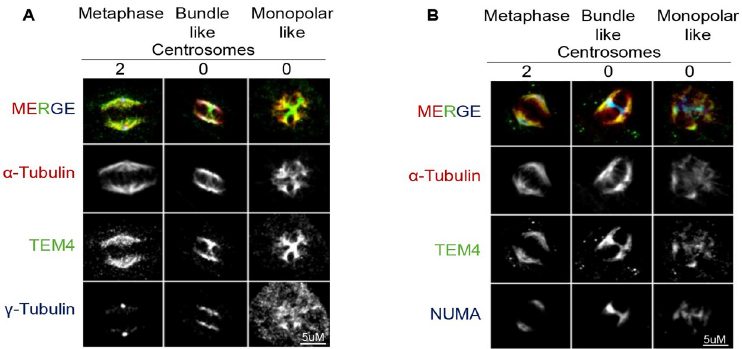
Fig 4. TEM4 and NuMA localize to similar microtubule structures in acentrosomal human cells. A: Immunofluorescent images of HeLa-T-REx cells treated with DMSO or 100 nM of centrinone for 72 hours. Cells were synchronized in mitosis after 10 hours of release from double thymidine block and fixed for 10 minutes with PTEMF buffer. Fixed cells were stained with anti-TEM4 (green), anti- α -tubulin for the spindle microtubules (red) anti- γ - tubulin (blue) to mark spindle poles. Scale bar = 5 μ m. B: Cells were treated as in A and then stained for NuMA (blue), TEM4 (green) and α -tubulin (red) in the presence or absence of centrinone as indicated. Scale bar = 5 μ m.